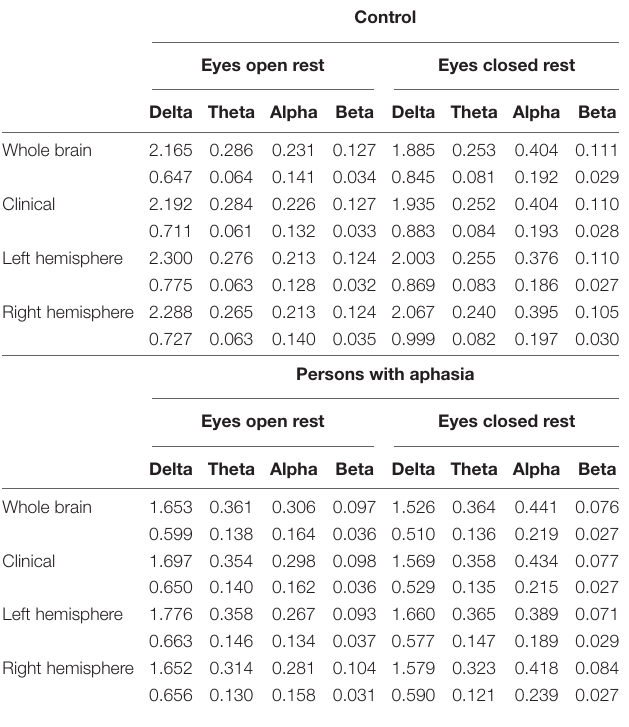
TABLE 4 | Mean (top number) and standard deviation (bottom number) of frequency bands in each montage during eyes open and eyes closed rest for controls and